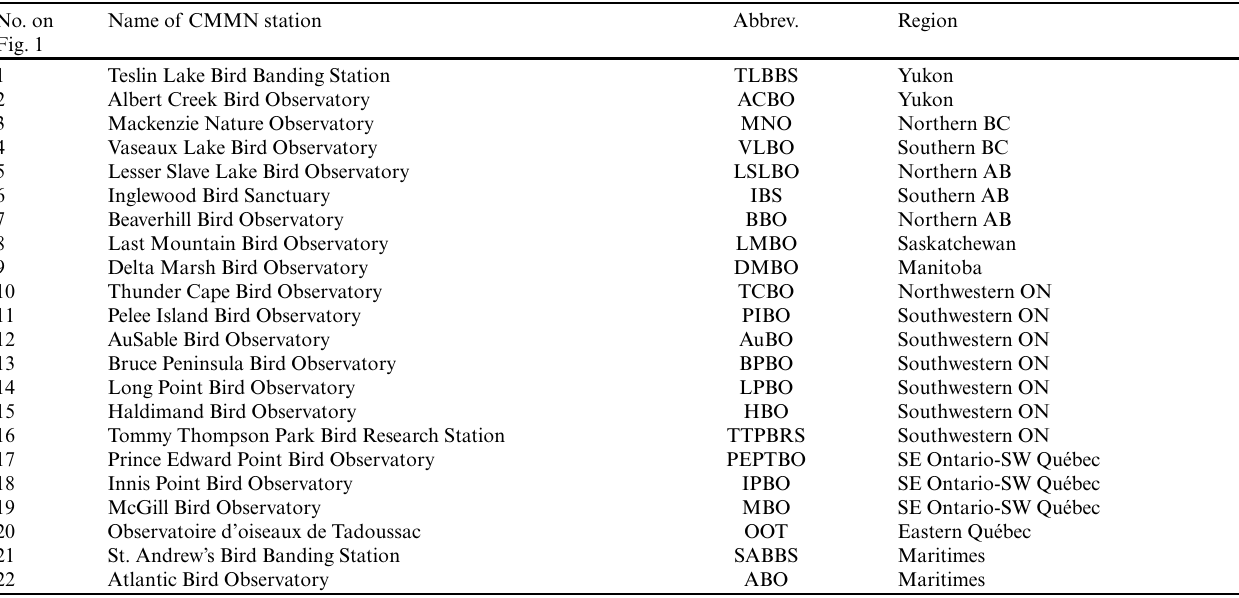
Table 2 . Canadian Migration Monitoring Network stations participating in study (Fig. 1). No. on Fig.